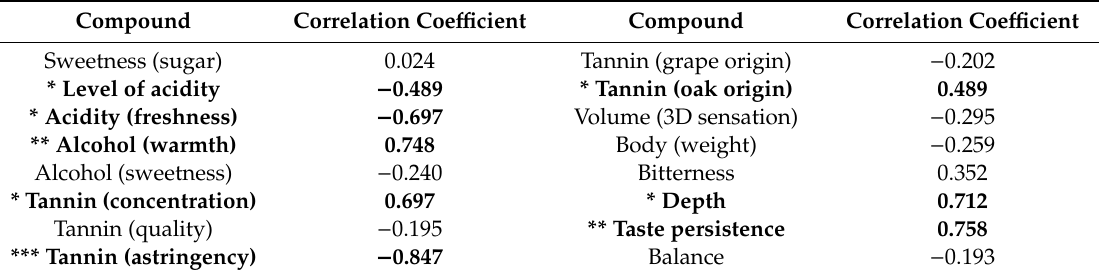
Table 7. Sensory descriptors with correlation at a significant level of 60% with the gustatory “minerality” attribute build from the data extracted from the six red wines of the study (in bold letters with